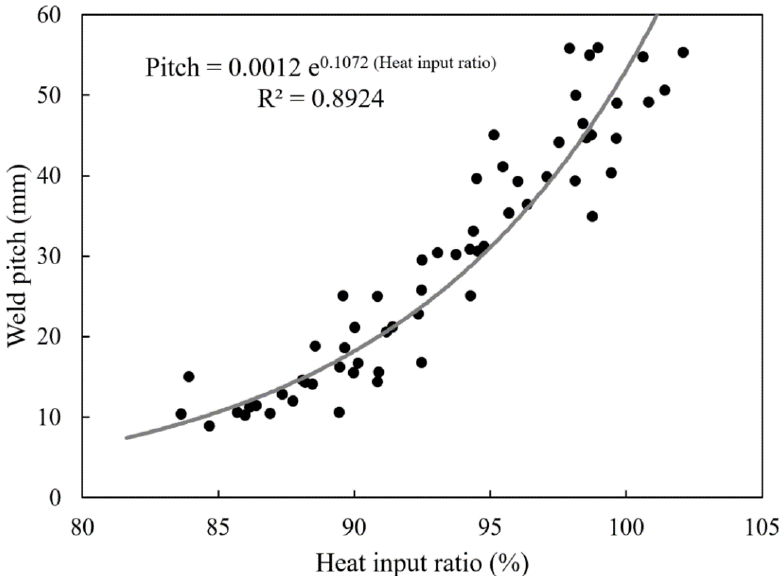
Figure 9. Heat input ratio parameter.